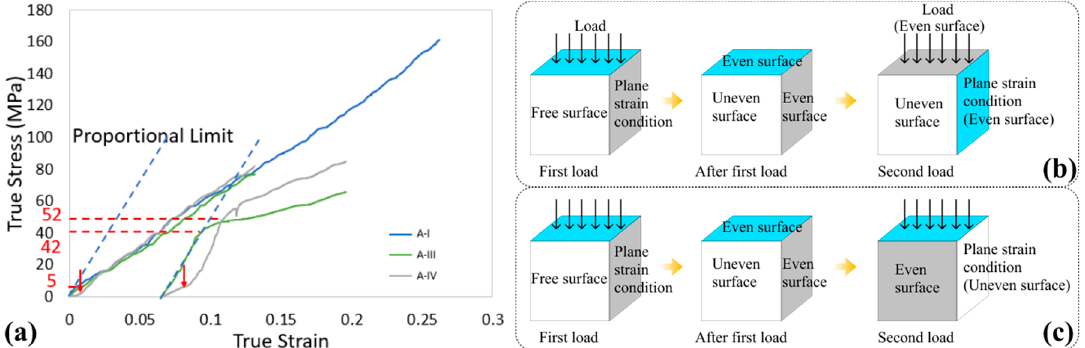
Figure 9. Two-directional compress test ( a ) experimental true stress-strain curve of PSC on single aluminum crystal under three strain paths A-I, A-III and A-IV, ( b ) surface conditions of case A-III and ( c ) surface conditions of case A-IV.